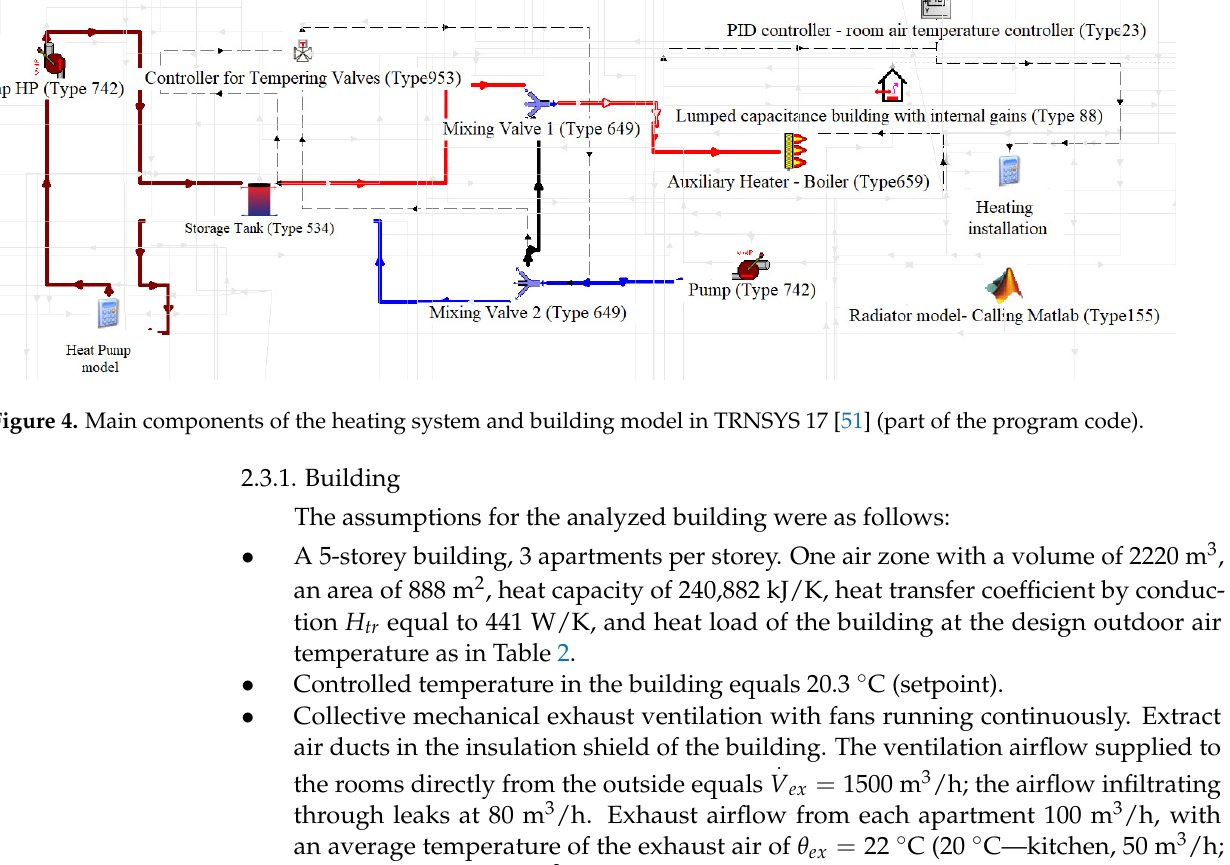
Table 2. Designated outdoor temperatures and heat loads of the building.